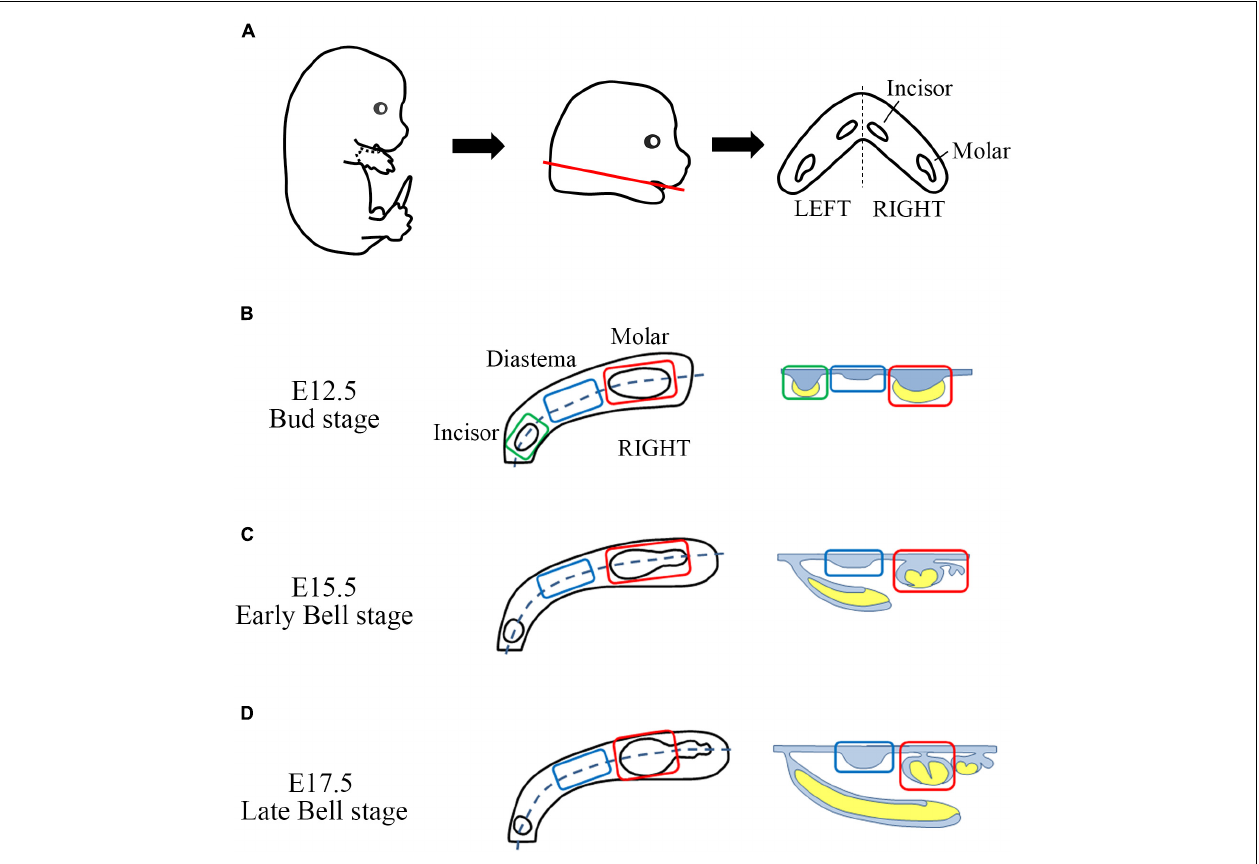
FIGURE 1 | Sample gathering scheme of mouse embryo odontogenic and non-odontogenic regions. (A) From E12.5, E15.5, and E17.5 embryos, the craniofacial region was dissected between the first and second branchial arches. Then the mandible was gathered (red line). The tongue was removed. The trimmed mandible has incisor and molar tooth germs as well as diastema regions on both sides. It was halved along the midline. (B) From the E12.5 mandible half, the aboral part was removed. The remaining oral part was divided into three parts (incisor, diastema, and molar). (C,D) From the E15.5 and E17.5 mandible halves, incisor region, mandibular bone, and forming alveolar bone were removed. The remaining half dental arch composited with the dental epithelium, and the underlying mesenchyme was divided into the diastema and molar